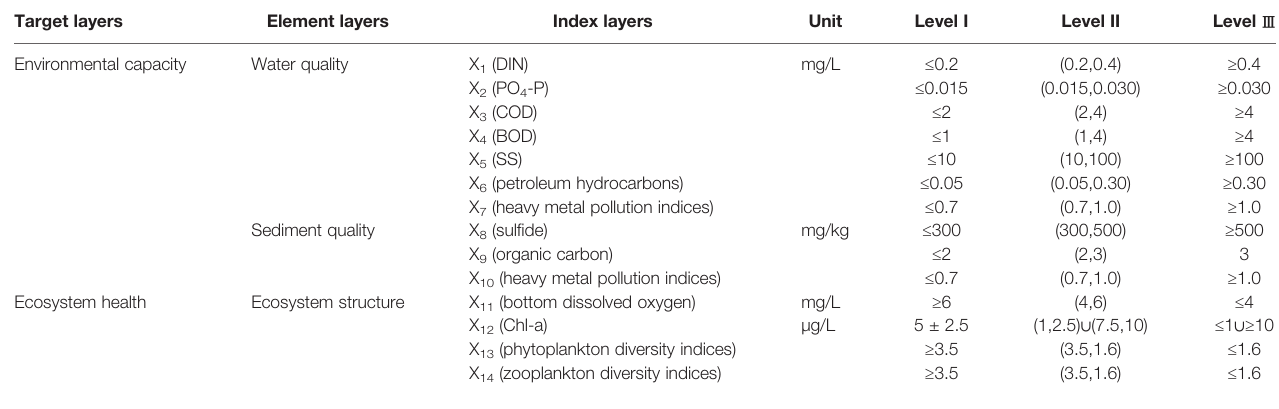
TABLE 1 | Evaluation system of the MEECC. Target